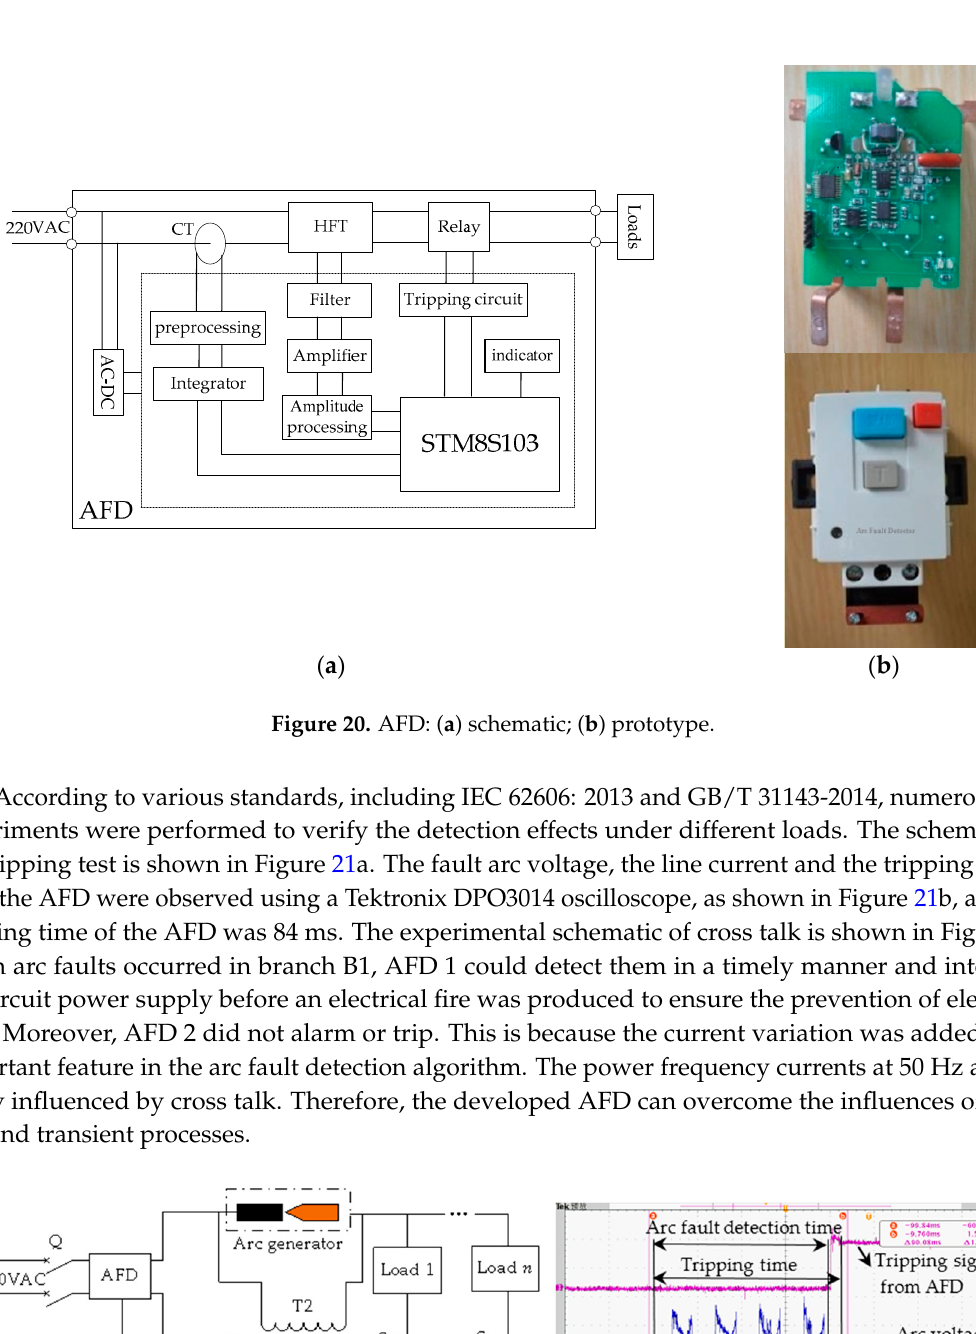
Figure 19. AFD: ( a ) schematic; ( b ) prototype. Figure 20. Tripping test: ( a ) schematic; ( b ) results. Table 4. Test results under typical loads.